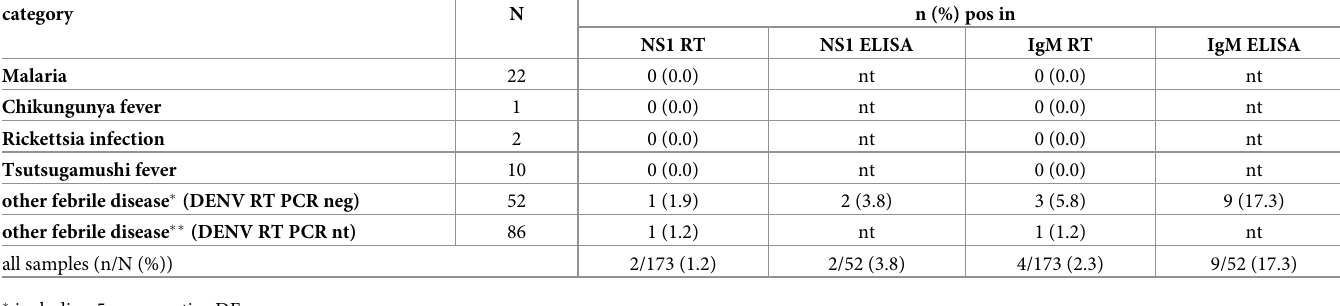
Table 2. Specificity of SD Bioline Dengue Duo NS1 (NS1 RT), Platelia NS1 Antigen ELISA (NS1 ELISA), SD Bioline Dengue Duo IgM (IgM RT), and Panbio DENV μ -capture ELISA (IgM ELISA).